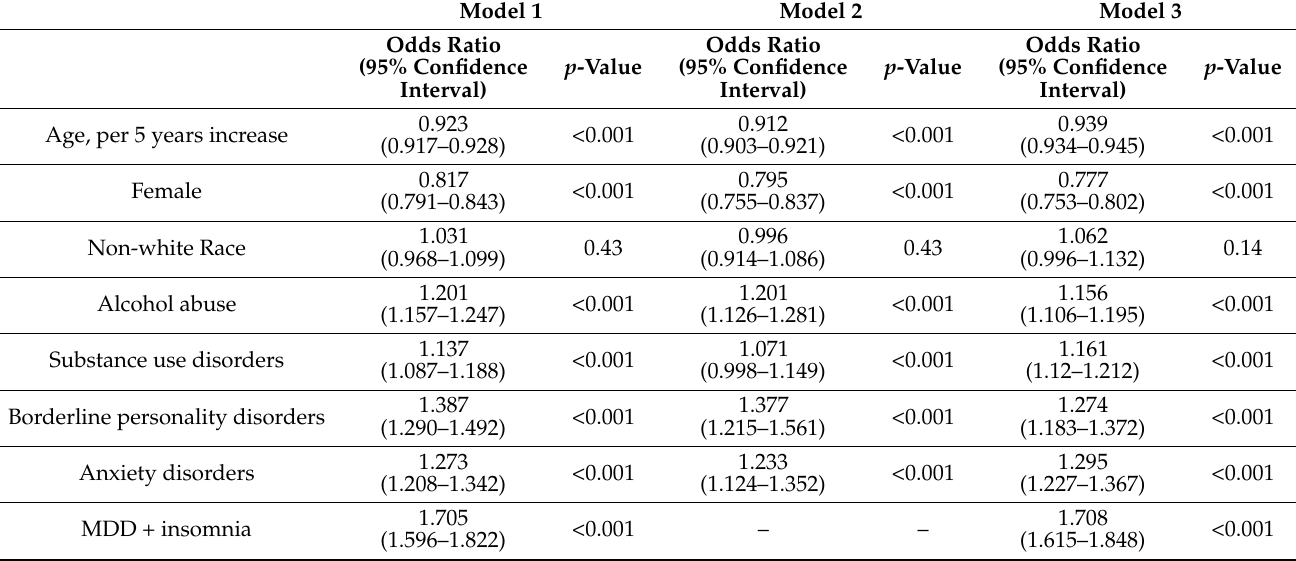
Table 2. Predictors associated with suicidal ideation/attempt among study